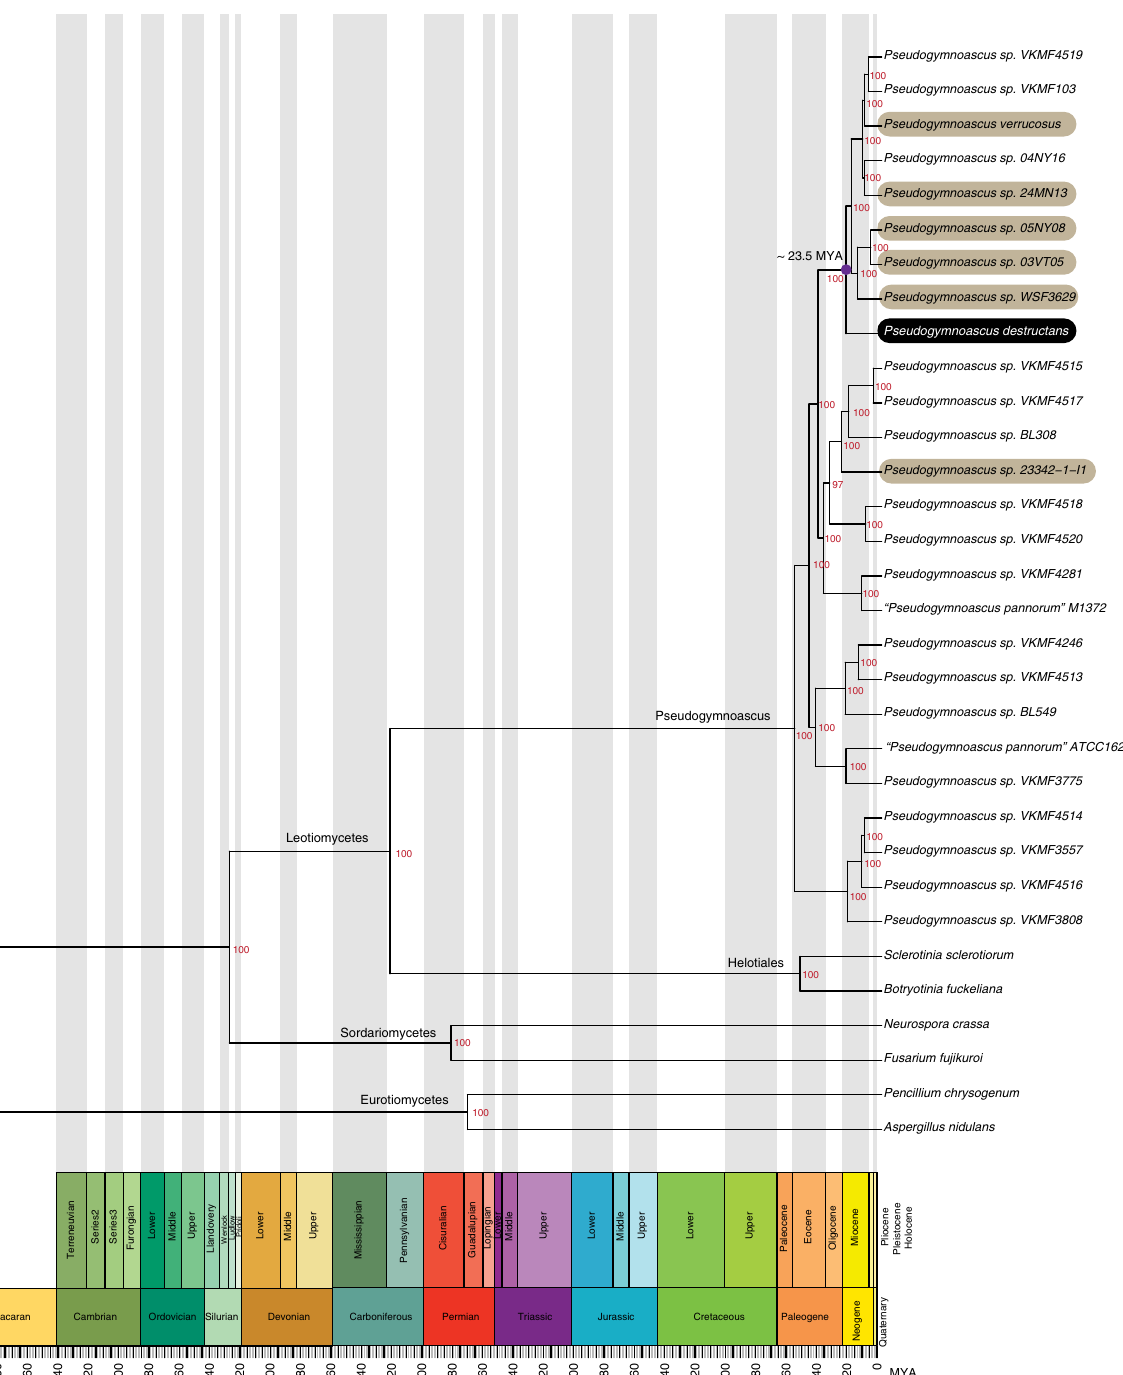
Fig. 1 Maximum likelihood phylogeny of Pseudogymnoascus draft genomes and several outgroup Ascomycetes calibrated using fossil evidence. The six nonpathogenic Pseudogymnoascus species sequenced here are among the closest known relatives of P. destructans . P. destructans was estimated to have diverged from its last common ancestor around 23.5 MYA. Node support values are derived from 1000 bootstrap